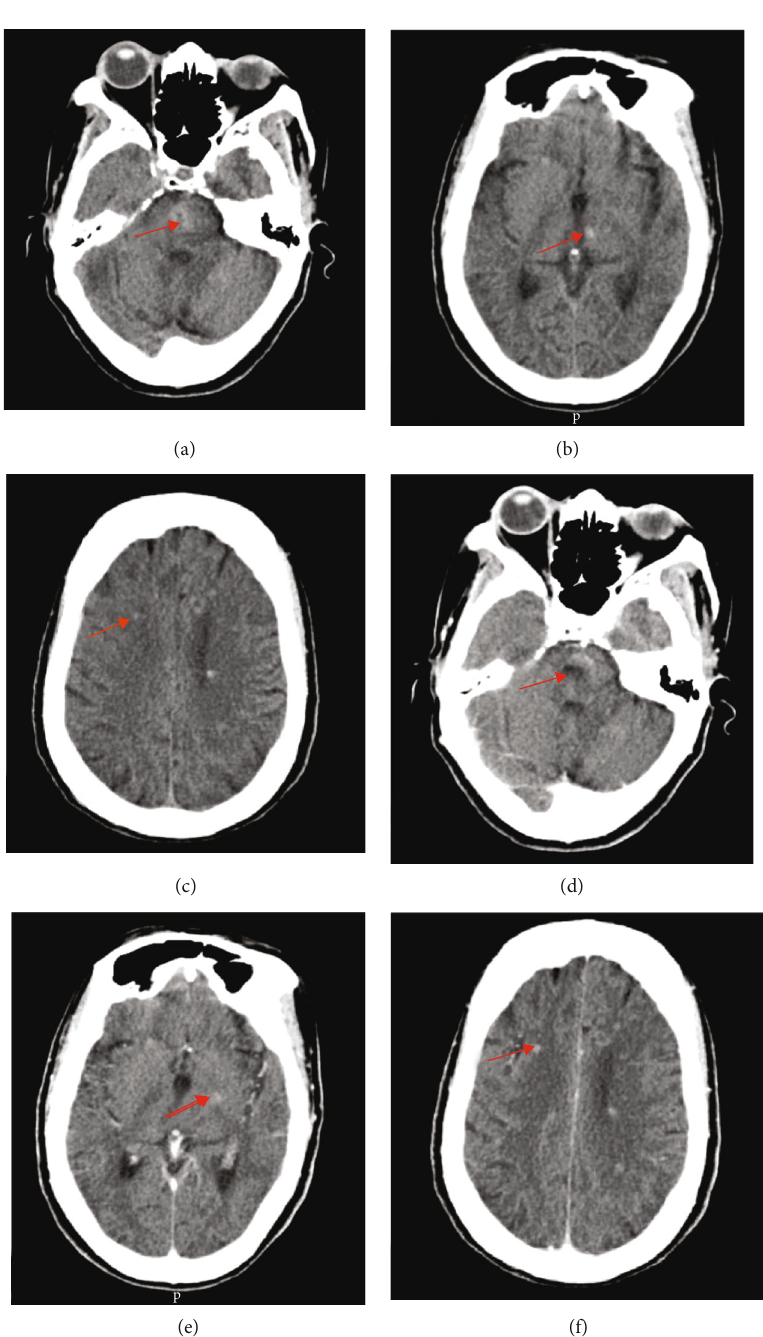
Figure 1: Axial (a – c) unenhanced and (d – f) enhanced cerebral computed tomography images showing multiple, di ff use hyperdense lesions in the infratentorial (pons), basal ganglia, and other supratentorial regions of the brain (red arrows) suggesting multiple cerebral